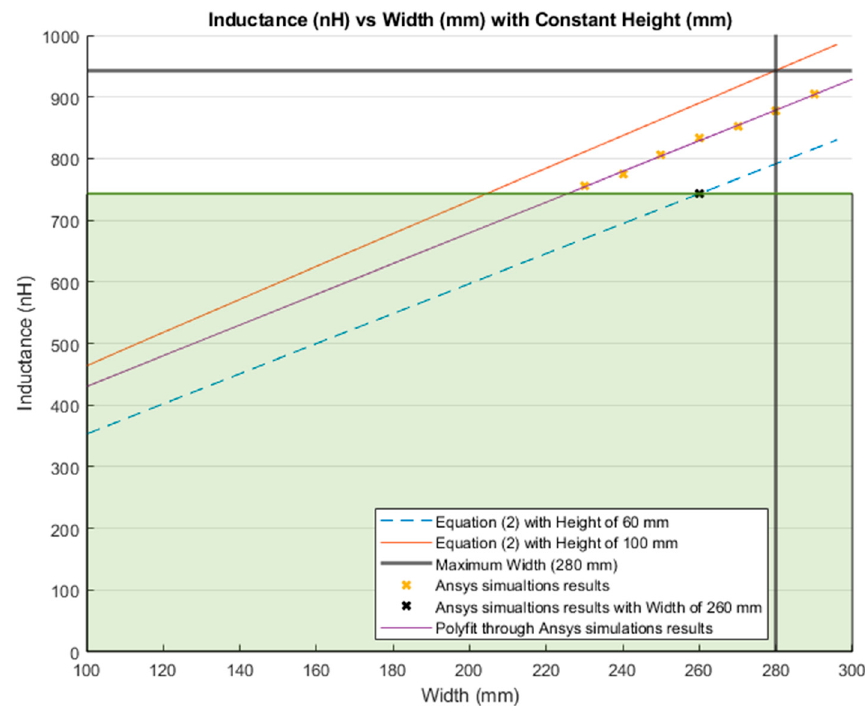
Figure 23. Inductance calculation with a constant height (mm) and a variable width (mm). High- lighted in green shading is 78.79% of the total inductance change.